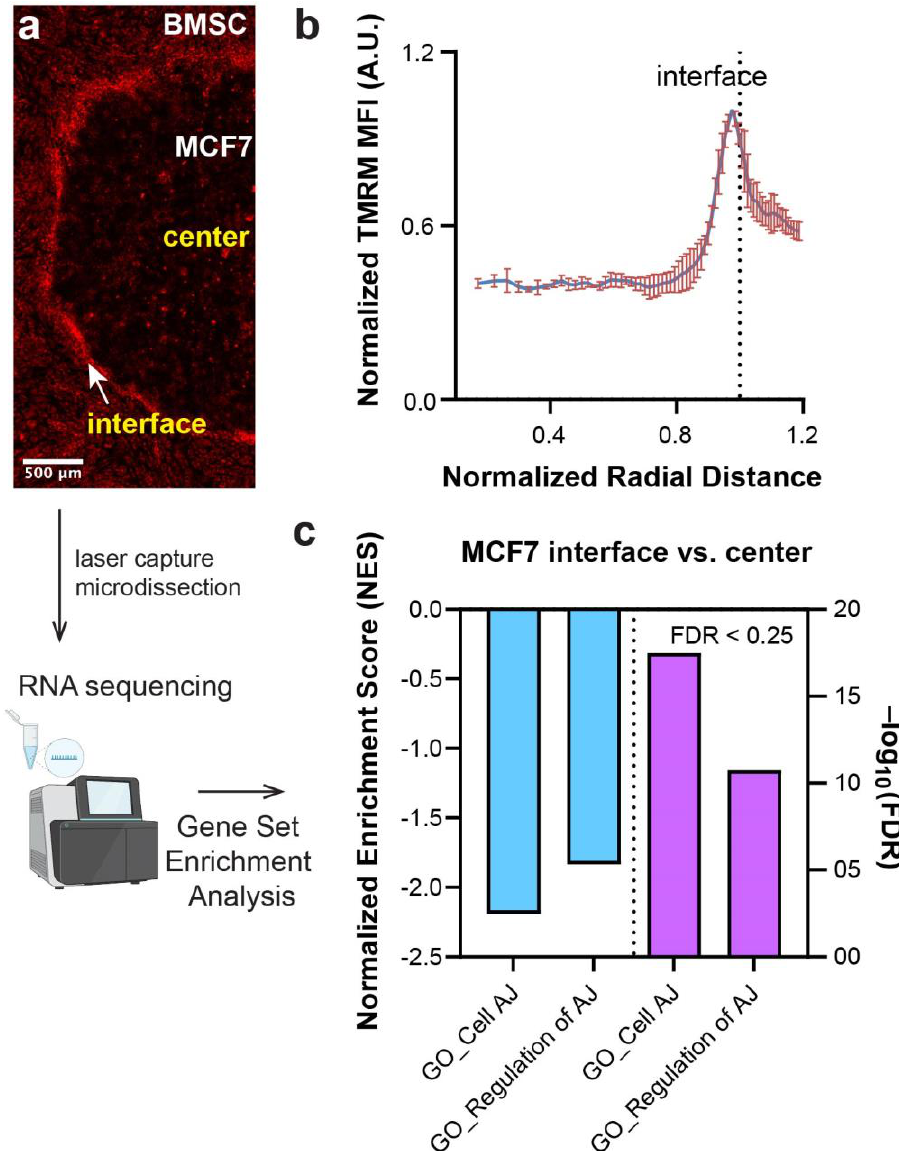
Figure 1. Spatial distribution of ΔΨ m of MCF-7 cells in micropatterned tumor model associated with regulation of cell adhesion. ( a ) Representative image showing TMRM fluorescence of a day 4 MCF-7-BMSC co-culture micropattern and ( b ) the corresponding normalized radial distribution. ( c ) Gene set enrichment analysis of MCF-7 cells at the tumor-stromal interface relative to MCF-7 cells at the center of the tumor island, following RNA-sequencing of laser capture microdissected from different locations of the micropattern as described in [6] with a false discovery rate (FDR) < 0.25.